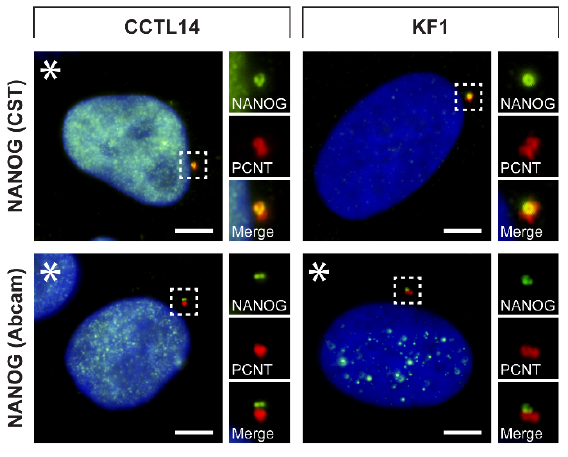
Figure 4. Centrosomal localization of NANOG in hESCs and normal fibroblast cells. The centrosomal localization of NANOG (green) was detected in CCTL14 hESCs and KF1 normal fibroblast cells using two anti-NANOG commercial antibodies (#4903, Cell Signaling Technology (CST) and #ab109250, Abcam) and anti-pericentrin antibody (PCNT; red). NANOG was also detected in the cell nucleus in the CCTL14 cell line and rarely in the KF1 cell line (indicated by asterisks). The nuclei were counterstained with Hoechst 33342 (blue). For each image, a region of interest is indicated by the dashed box, and the respective close-ups are provided on the right. Scale bars, 5 μ m.